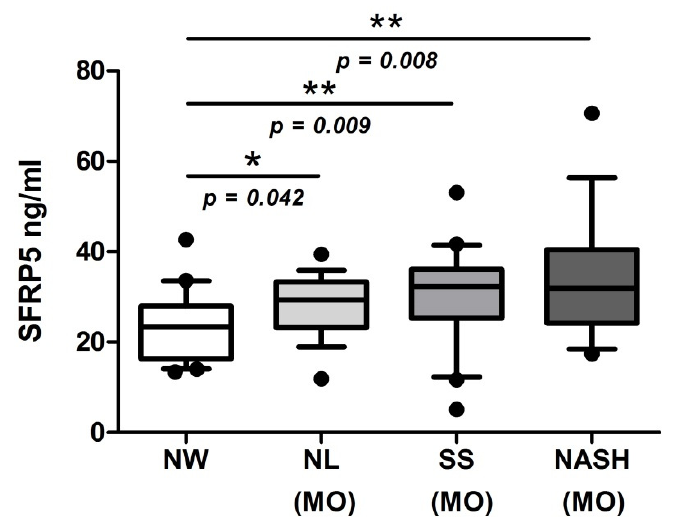
Figure 2. Box plot graphical representation of serum levels of SFRP5 women with NW and women with MO subclassified according to NL, SS, and NASH. NW, normal weight; MO, morbidly obesity; NL, normal liver; SS, simple steatosis; NASH, nonalcoholic steatohepatitis; SFRP5, secreted frizzled-related protein 5. Individual data points outside the maximum and minimum limits represent outliers. p < 0.05 was considered statistically significant (* means p < 0.05; ** means p < 0.01).